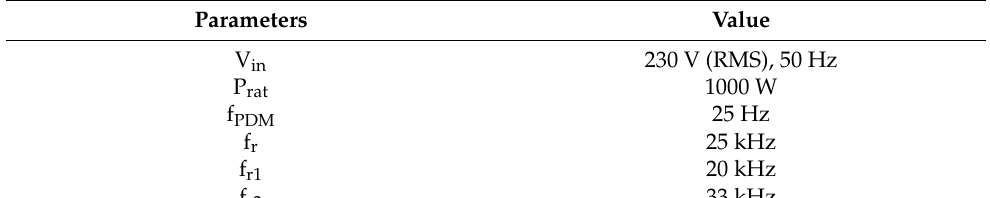
Table 2. Specific requirements.